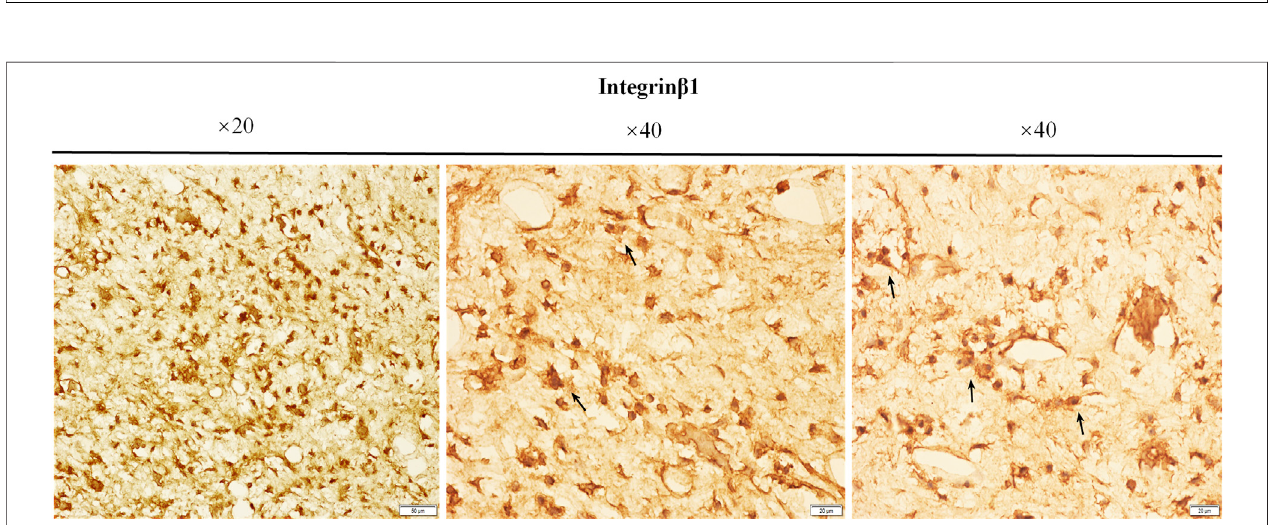
FIGURE12| Theexpressionsofintegrin β 1.Theparaf fi nsectionsofbonesamples21 daysaftertheexternalcapimplantsgrafted,andtheexpressionofintegrin β 1 was detected by immunohistochemical staining. The brown-yellow particles indicated the positive expression of integrin β 1.